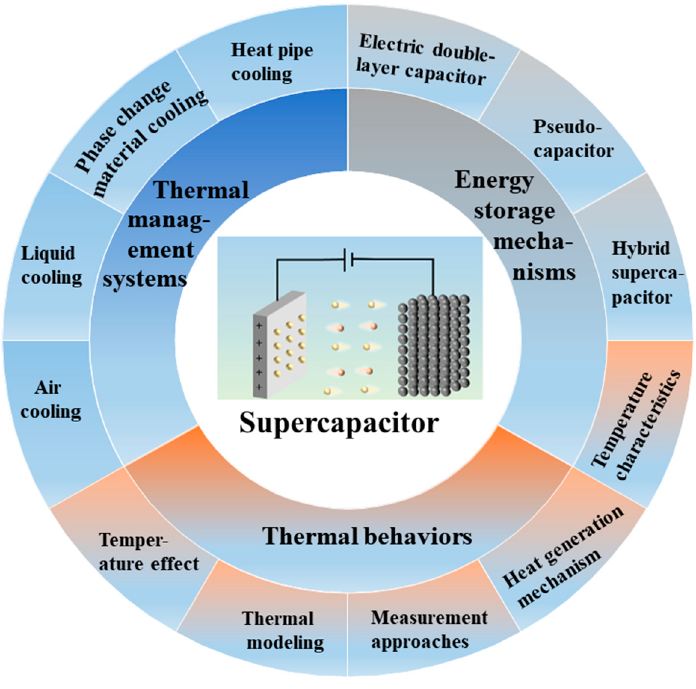
Figure 1. The outline map for this paper.